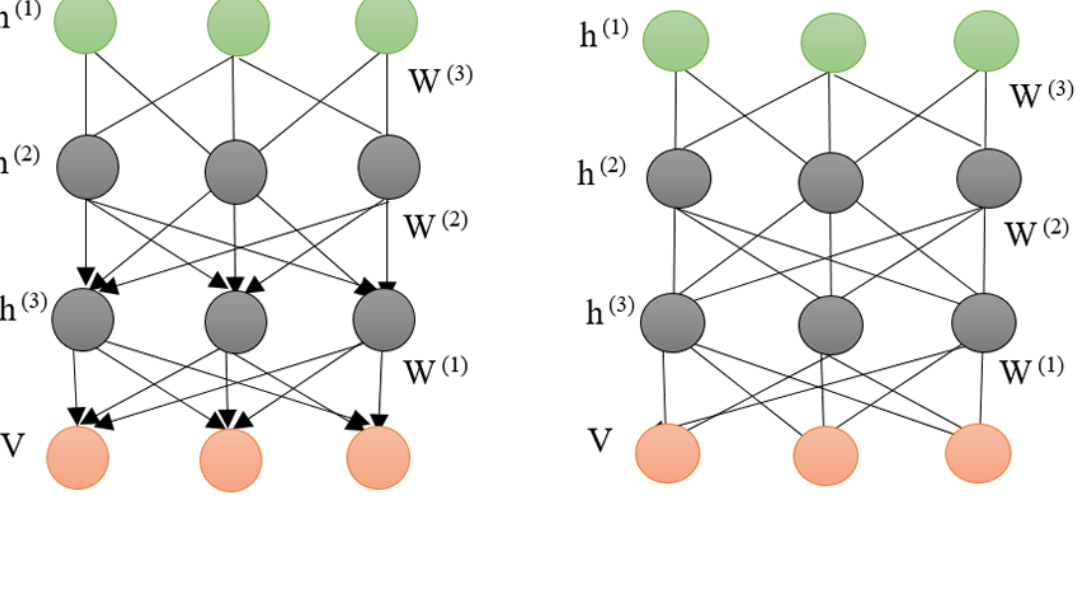
Figure 11. Left: A 3-layer deep belief network. Right: A stack of modified restricted Boltzmann machine constructed to create a deep Boltzmann machine. V: visible vector; h: a set of hidden neurons; w: